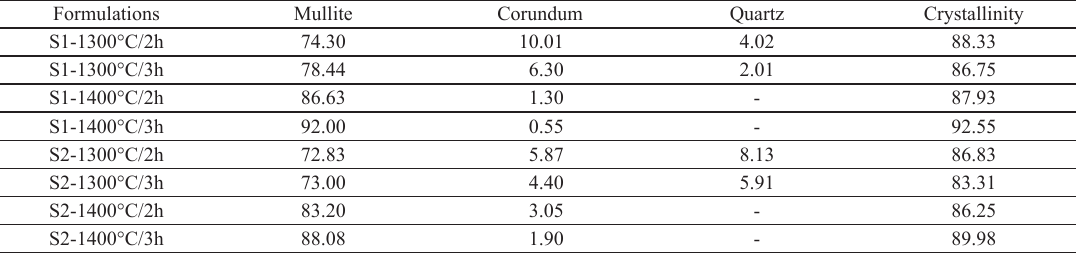
Figure 3. XRD patterns of S1 and S2 test specimens sintered at 1300ºC and 1400º C. M = mullite ; Q = quartz ; α = α-Al Table 2. Percent composition of phases in formulations S1 and